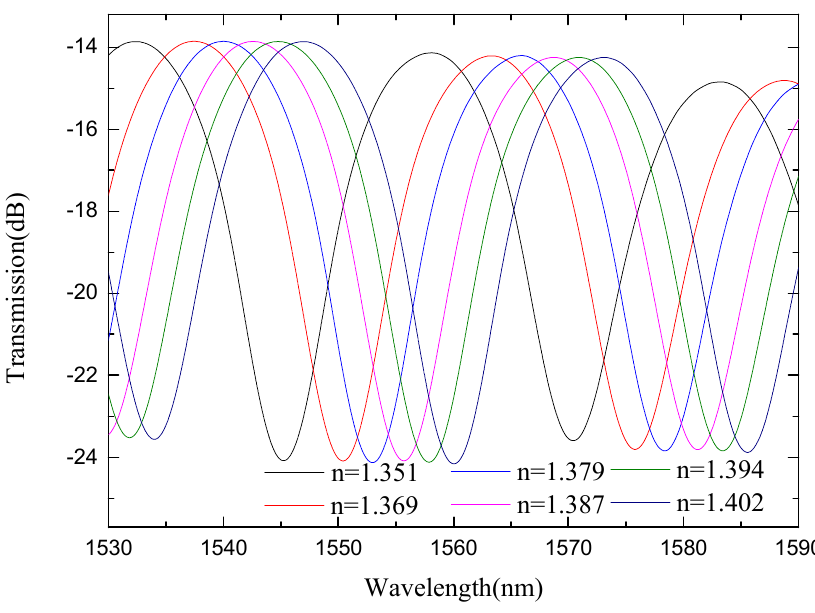
Figure 18. Spectra of ESMBMS MZI(1/3L) with the position of the bitaper set to one third of the sensing arm at different refractive indices.